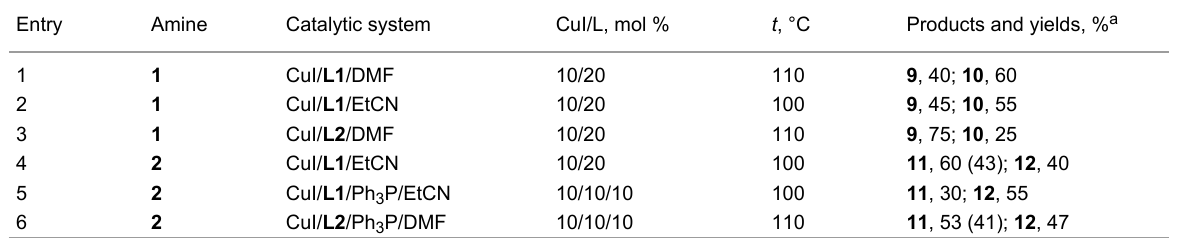
Table 1: Optimization of the reaction conditions for the N , N ’-diarylation of diamines 1 and 2 with iodobenzene.